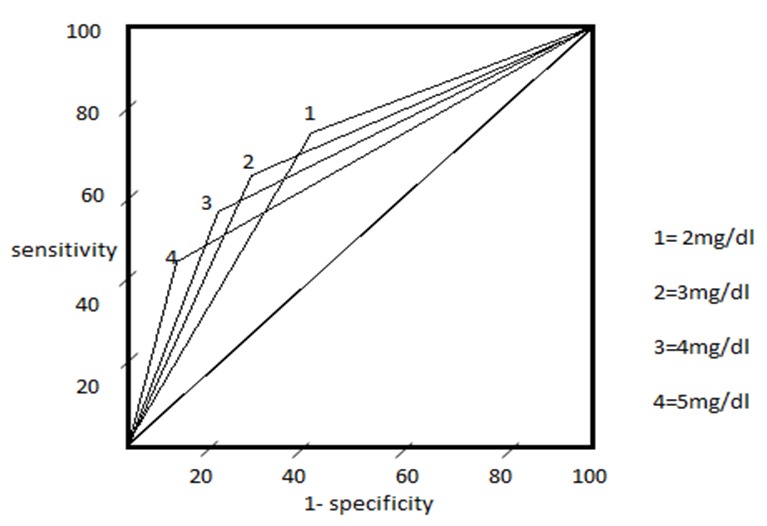
Receiver Operating characteristic (ROC) curves for different values of Bilirubin